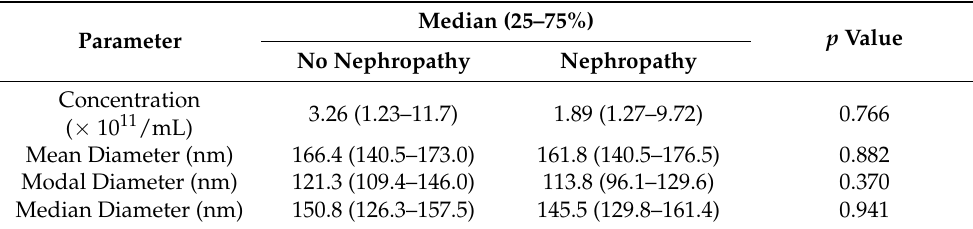
Table 4. Medians of concentration, mean, modal, and median diameter in FD patients without ( n = 9) and with ( n = 11) nephropathy at last